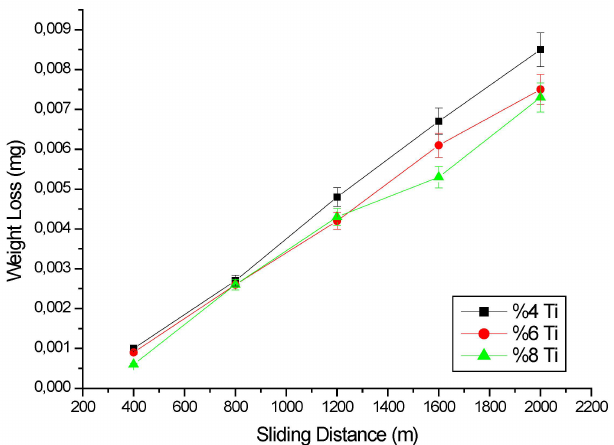
Figure 6. Weight losses of the samples depending on the sliding distances.